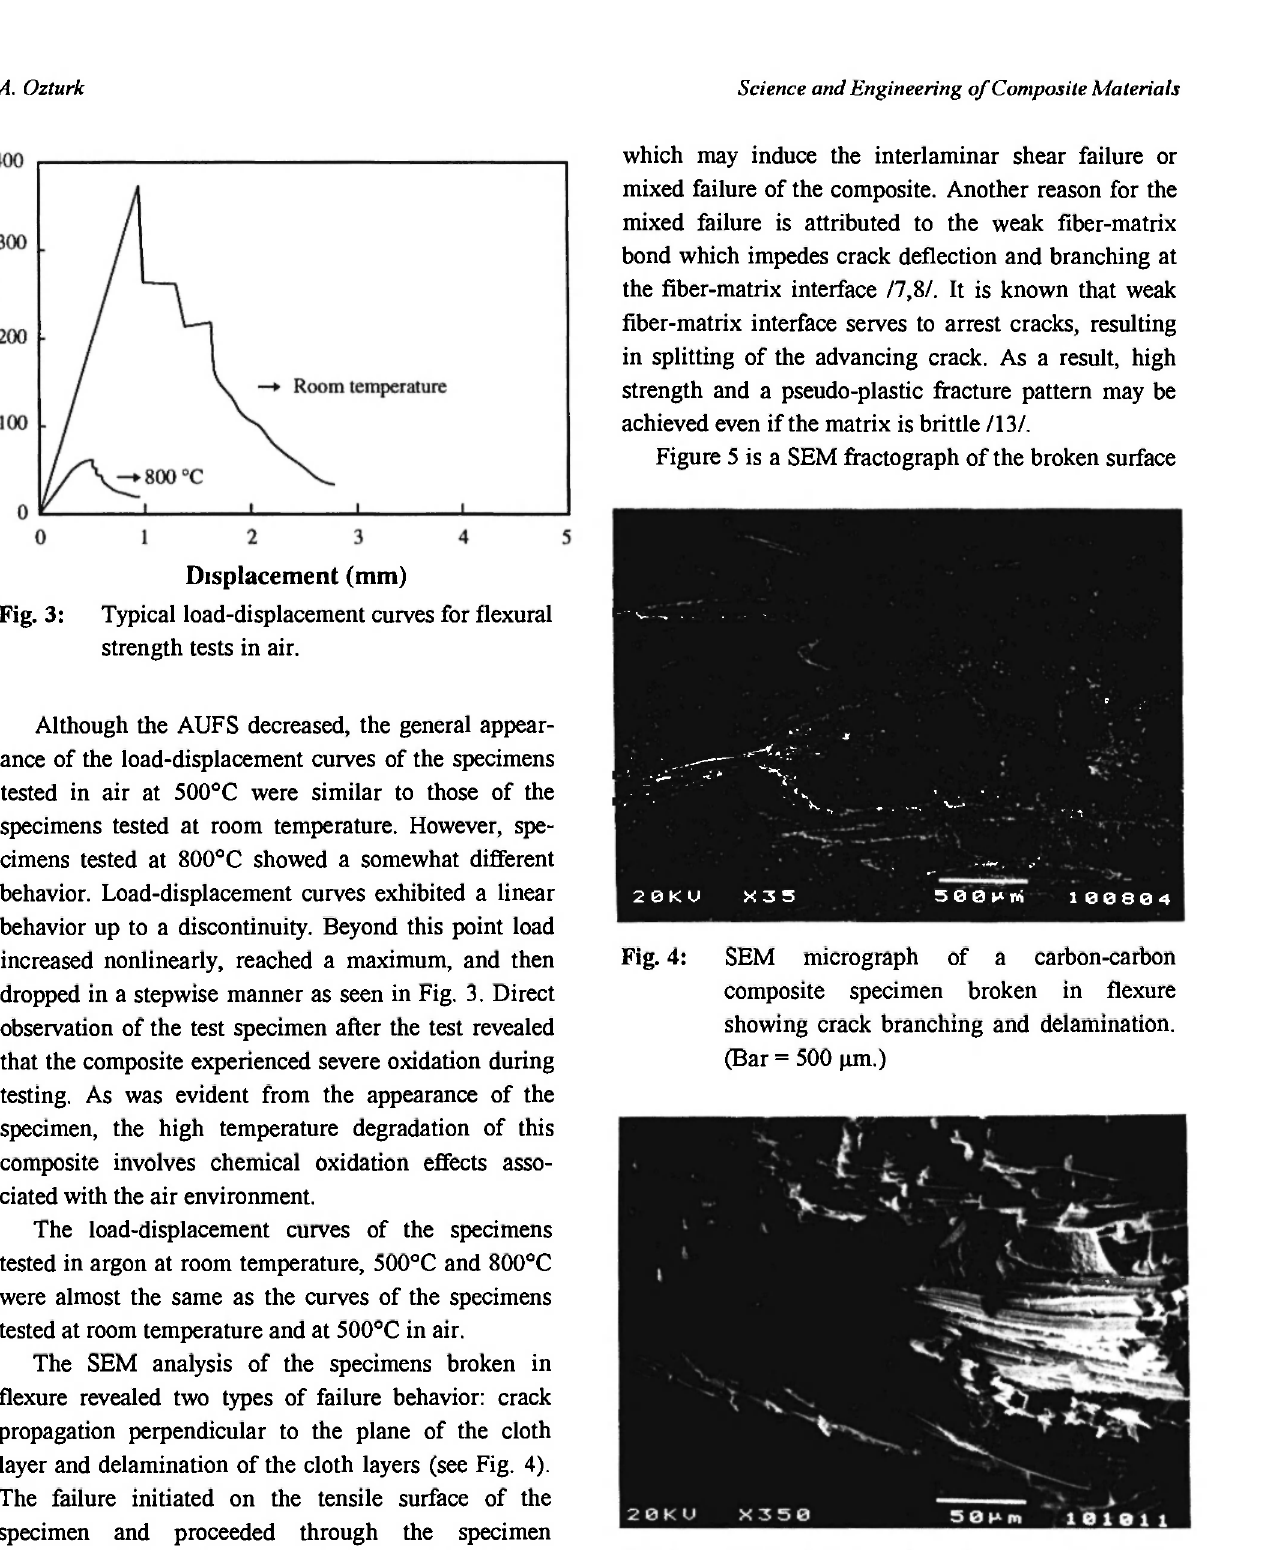
Fig. 5: SEM fractograph of a carbon-carbon composite specimen broken in flexure showing the separation of matrices, fiber bridging and fiber pull-out. (Bar = 50